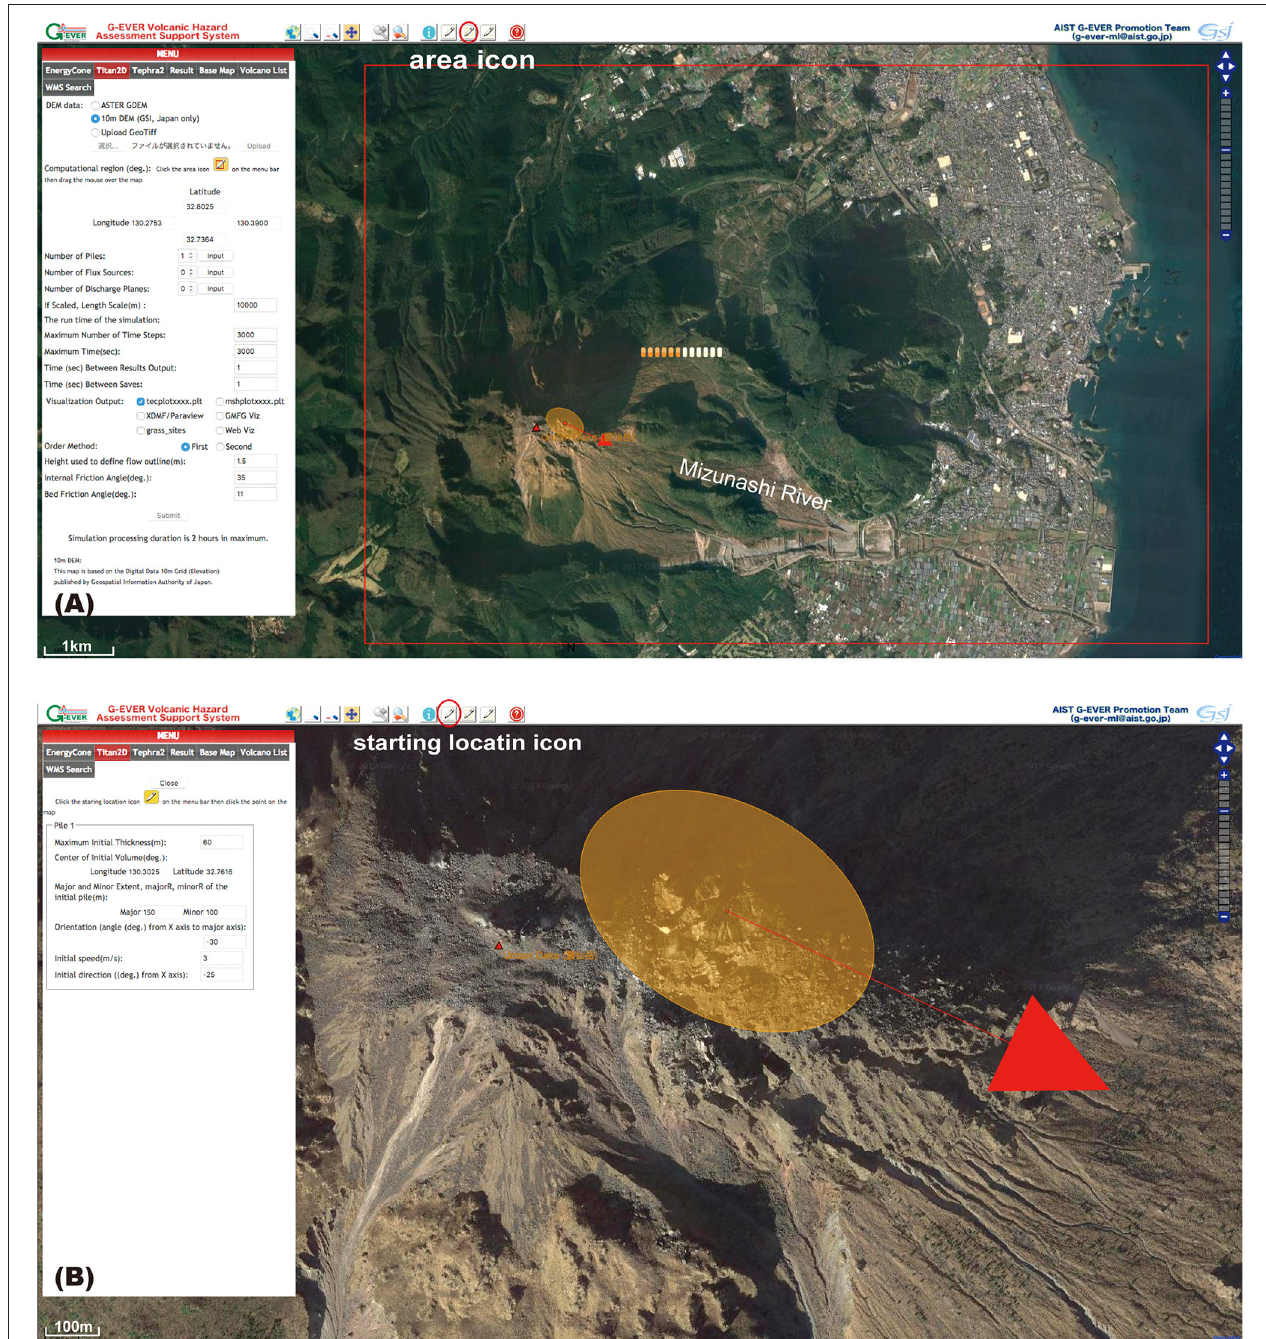
FIGURE 7 | Titan2D simulation at Unzen Volcano, Japan on the VHASS system. (A) Titan2D simulation menu on VHASS. The red square indicates a simulation calculation area. (B) The pile location, size (major and minor extent), elongation angle, the initial velocity and direction are visualized on Google maps.